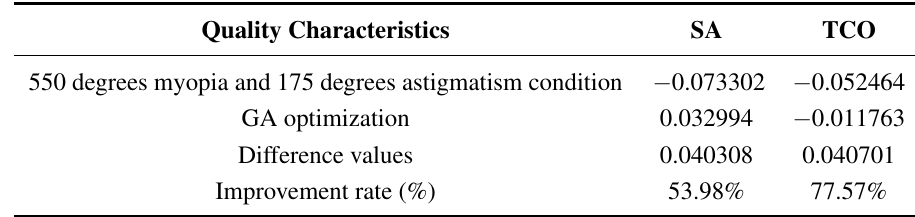
Table 10. Improvement rate of third-order aberrations after applying the proposed GA optimization method for pupil size 5 optimization method for pupil size 5 mm.